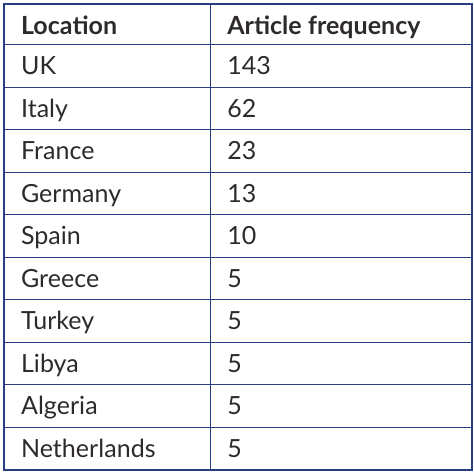
Table 5: Ten most frequent case study locations utilised in TRAC